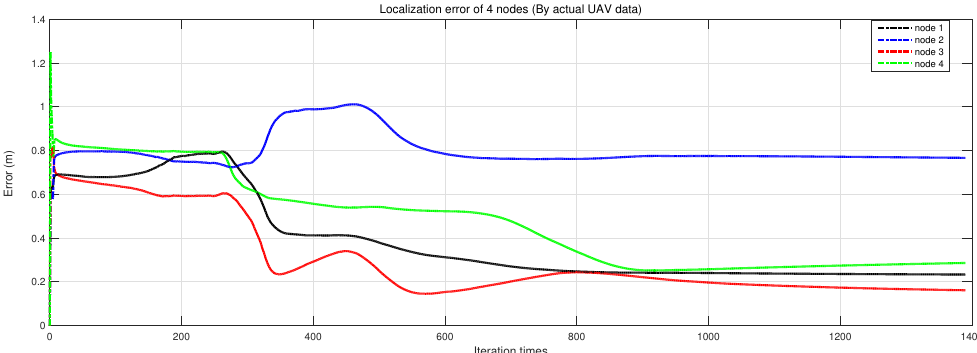
Figure 9. Localization error of UWB nodes in a physical